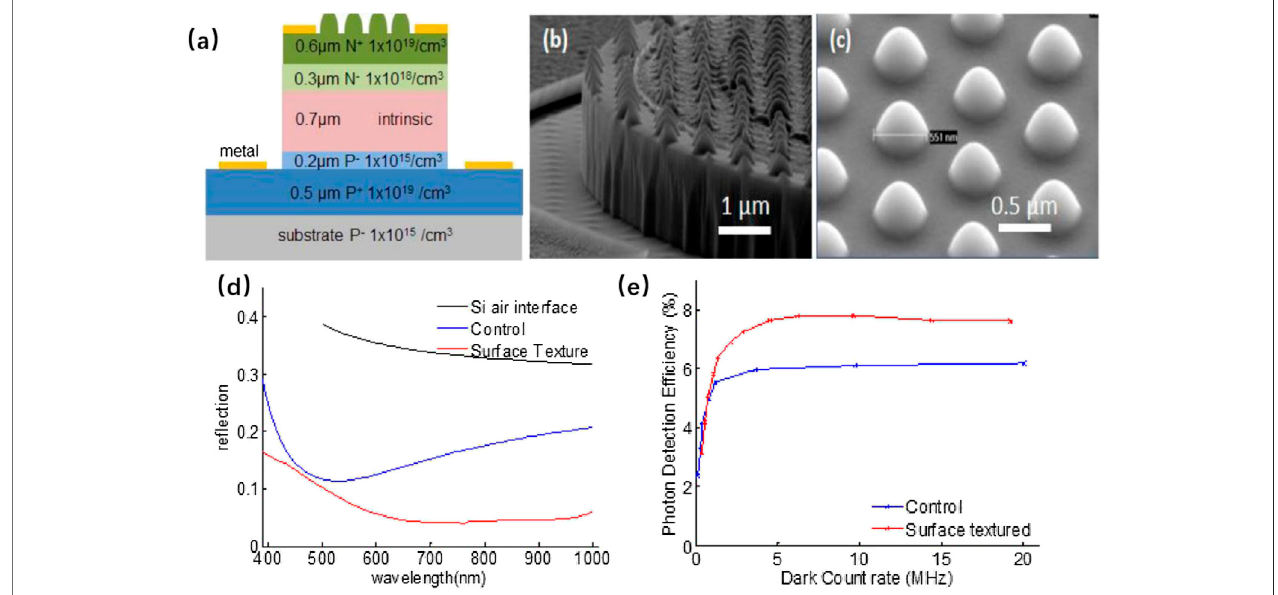
FIGURE12|(A) SchematicofepitaxiallayerandsurfacetexturedSPAD. (B) FabricatedSPAD. (C) Surfacenano-structure. (D) Re fl ectionmeasurementfromSi-air interface, control SPAD mesa top and surface textured SPAD mesa top (E) PDE vs. DCR for both SPADs. Source : Reproduced from Ref. 33.